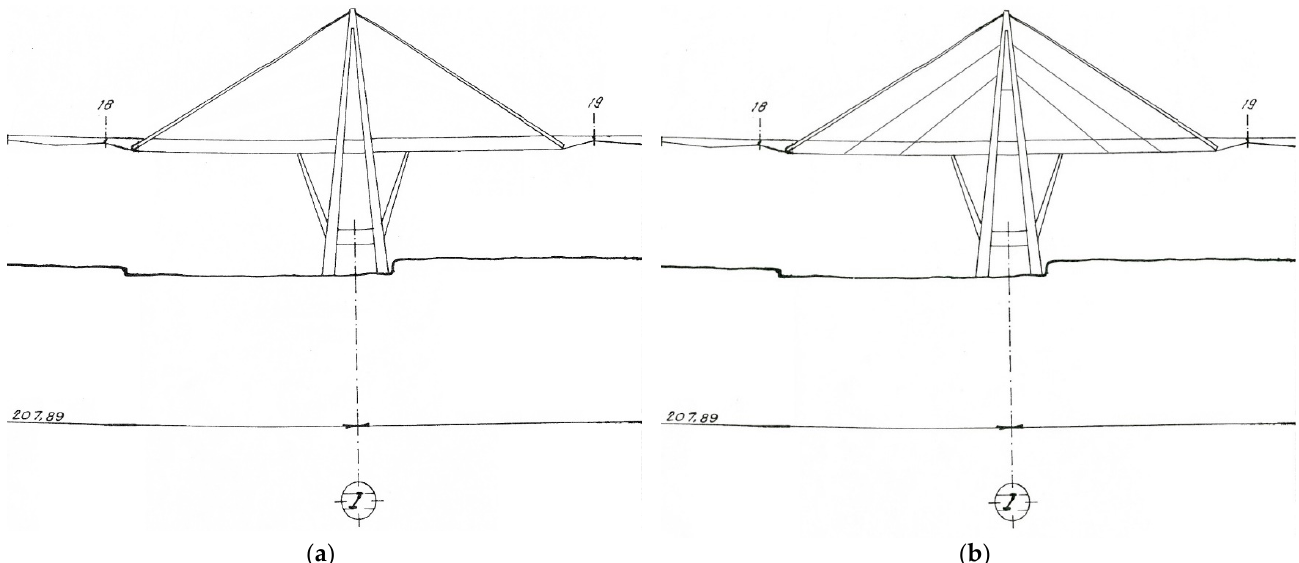
Figure 10. ( a ) Support No. 10 of the viaduct before strengthening. ( b ) Strengthening of support No. 10 of the viaduct according to the concept of Rymsza of 1993.